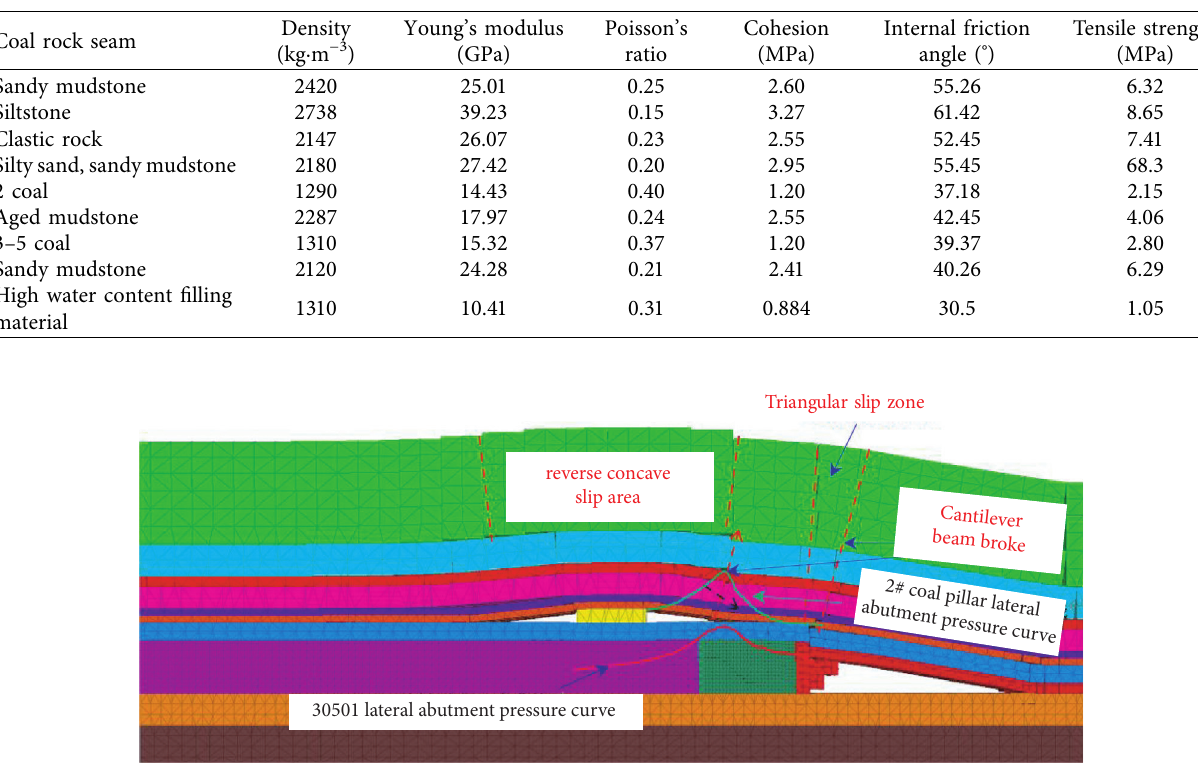
Table 1: Physicomechanical parameters of the coal rock block.